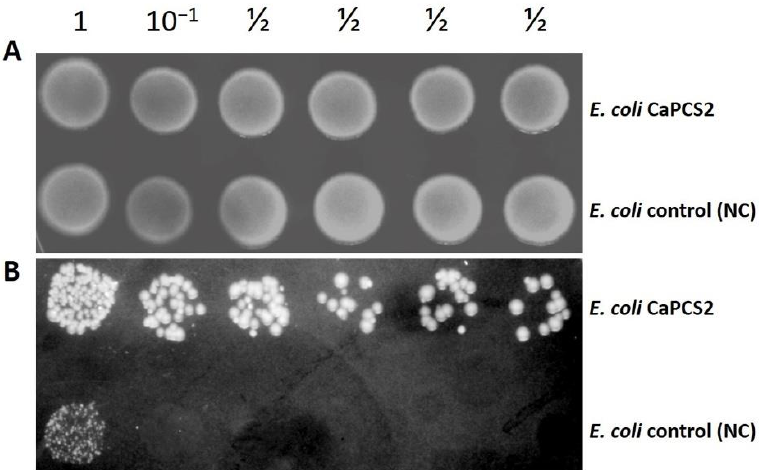
Figure 3. Drop test using serial dilutions of E. coli NC and CaPCS2 strains. ( A ): control assay with cells not exposed to UVB. ( B ): cells exposed to UVB (4 mJ cm −2 ).